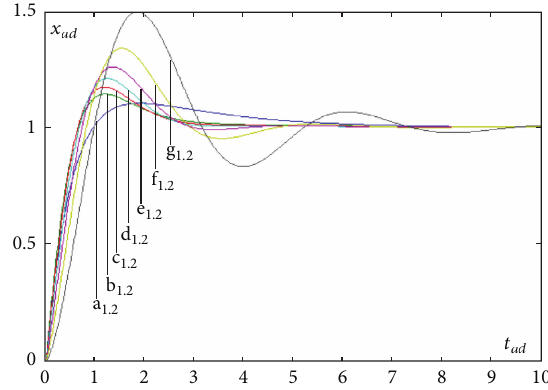
Figure 7: 𝑥 𝑎𝑑 as function of 𝑡 𝑎𝑑 , parameter sets of Table 1.